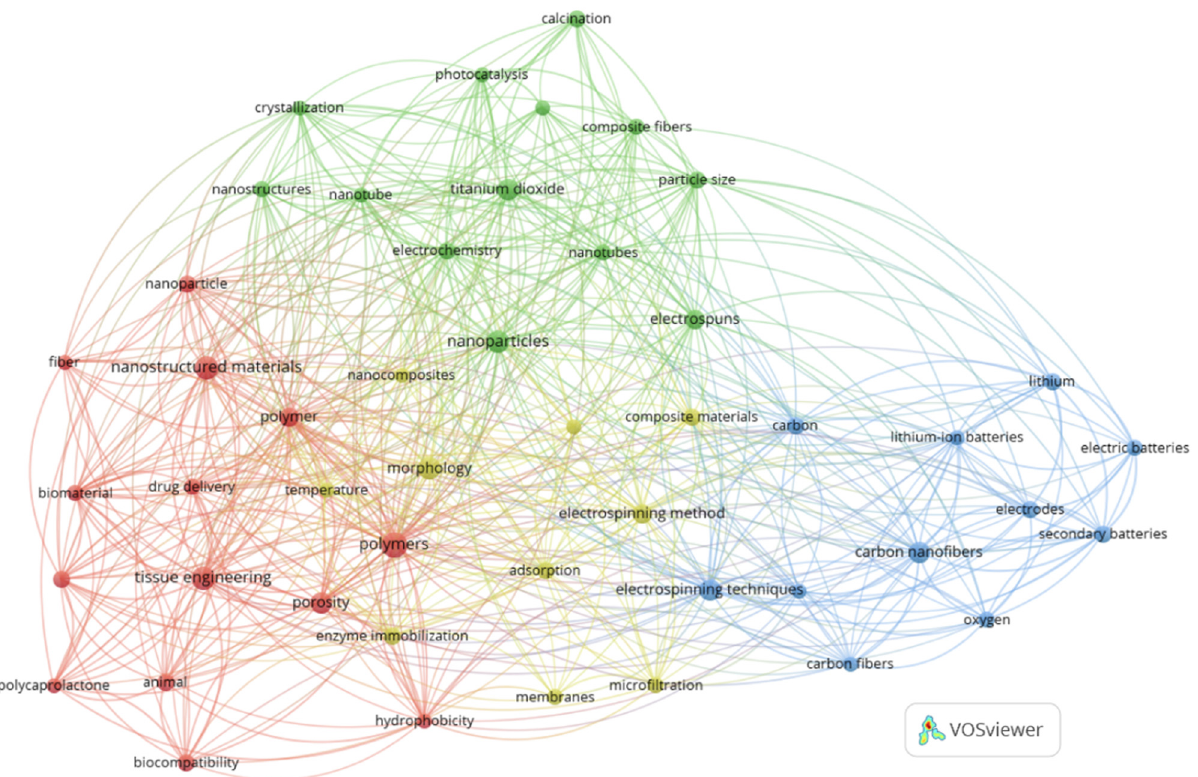
Figure 1. Bibliometric map of 48 keywords from the top 200 cited articles Scopus indexed for electrospinning, fibers and catalysis or catalysts. 4 clusters are identified. The size of the circle and font are proportional to the number of articles.